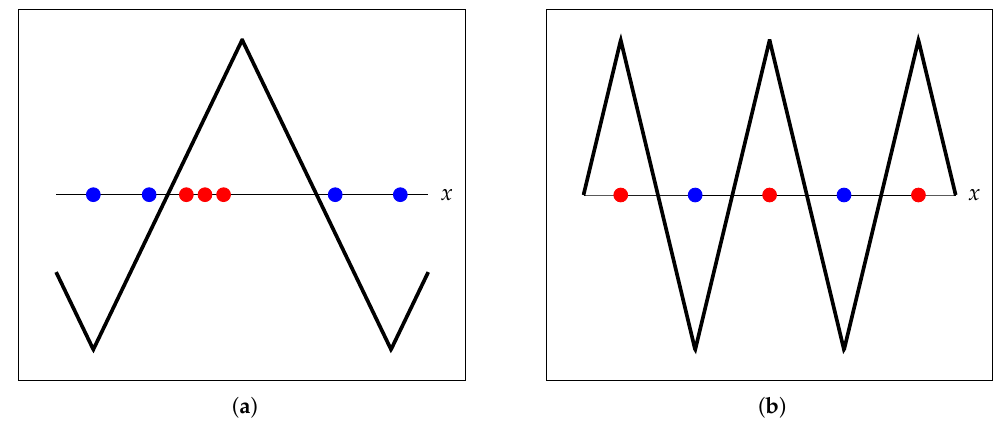
Figure 3. Example illustrating the benefits of composite kernels. ( a ) Toy example correctly solved by the primal and the kernel formulation (using the directional kernel g t ). ( b ) Toy example not solved correctly by the primal, nor the kernel with g t . Solved correctly with polynomial directional kernel of degree